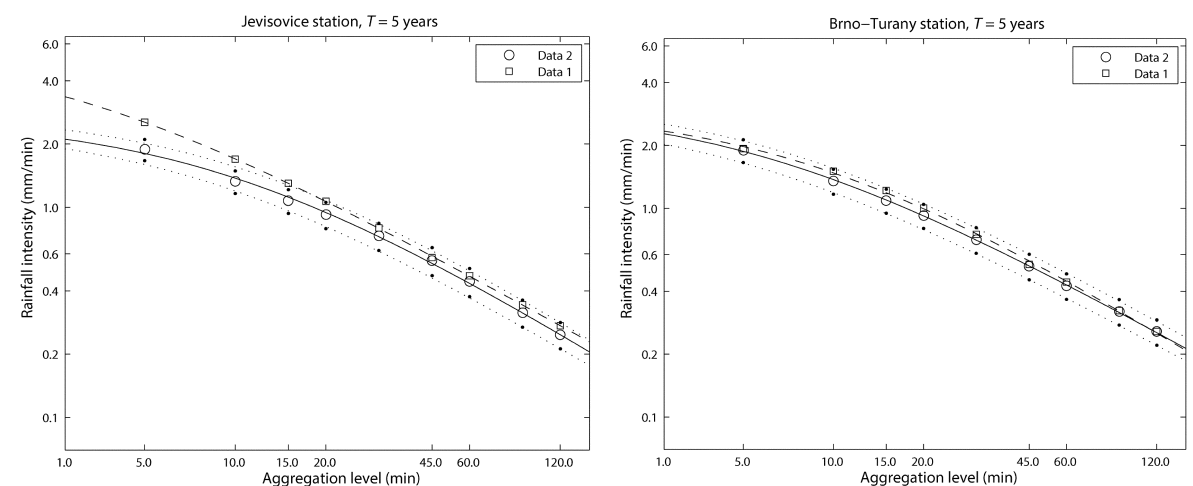
Fig. 8. Comparison of the IDF curves calculated using the GP distribution from Data 2 (95% confidence intervals denoted by dotted lines) with the empirical ones calculated from Data 1; logarithmic scales on both